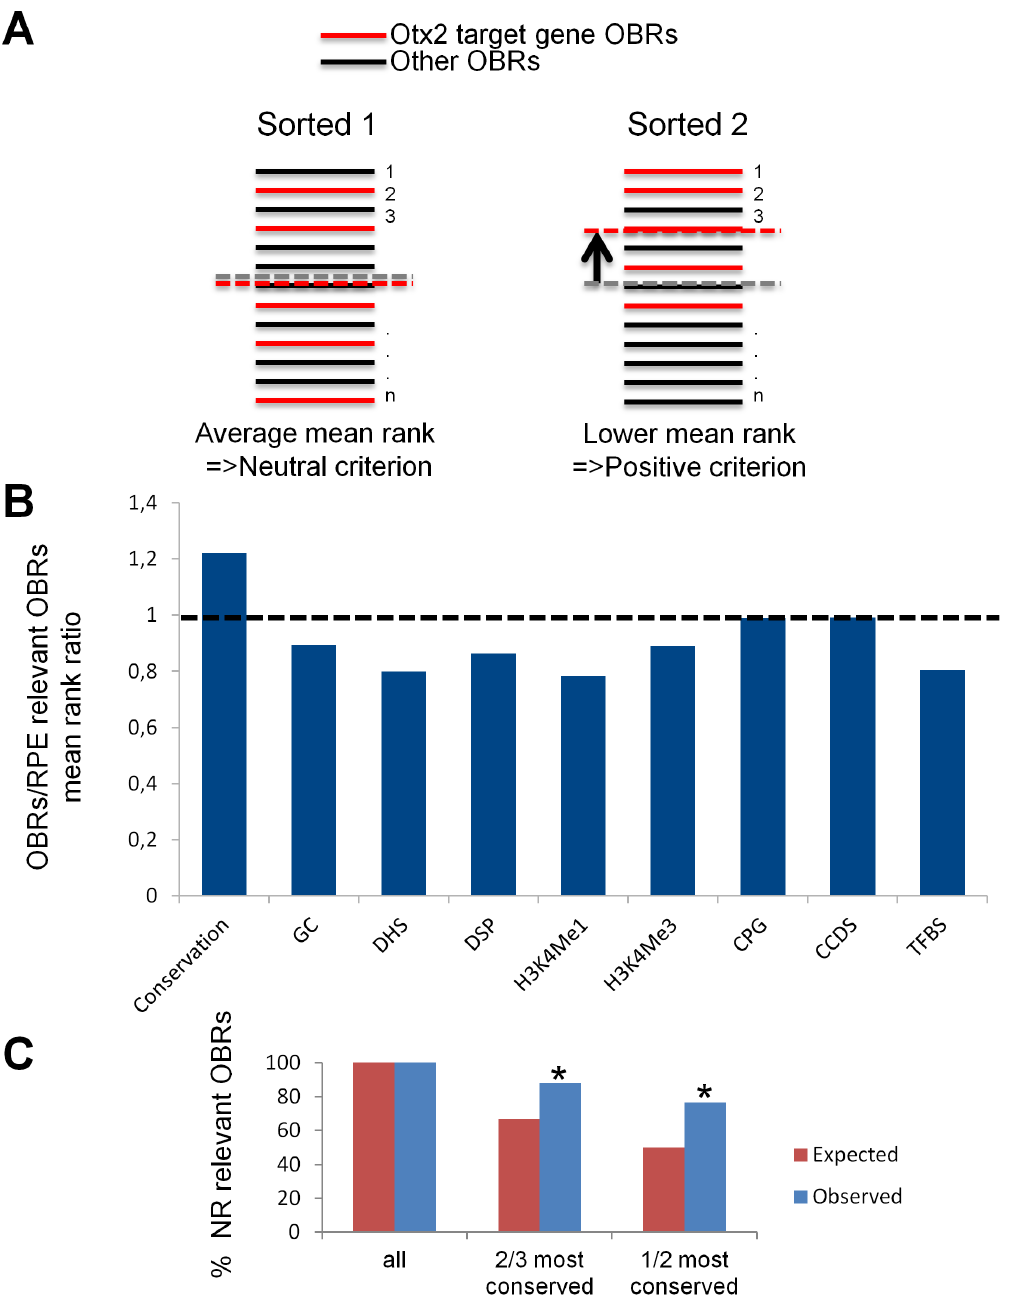
Figure 3. Evolutionary conservation marks OBR relevance. A. Principle of the relevance assay method: OBRs are sorted according to a given criterion and the mean rank of OBRs close to Otx2 target genes (red) is compared to the average mean rank of all called OBRs according to this criterion. A similar rank indicates a neutral criterion and a lower rank indicates a relevant criterion. B. Shown is the ratio of all OBRs mean rank to the mean rank of OBRs close to microarray confirmed Otx2 target genes according to evolutionary conservation, GC content, DNase hypersensibility (DHS) DNase sensibility and sensibility peaks (DSP), histone H3 lysine 4-mono- and tri-methylation (H3K4Me1, H3K4Me3), CpG islands (CPG), Consensus Coding sequences (CCDS) and known transcription factor bound regions (TFBS). The dashed line at the value of 1 represents the neutrality of all criteria. C. Application of the conservation criterion to the NR: expected and observed percentage of OBRs close to genes relevant to neural retina Gene Ontology terms among the 2/3 and 1/2 most conserved OBRs. doi:10.1371/journal.pone.0089110.g003 bracketed the Crx group, showing closer similarity to this Crx Next, the Otx2 NR and RPE core datasets were compared to group than to the Otx2 RPE group. This indicated that Otx2 the Crx ChIP-seq data in detail (Fig. 5B). Peak location analysis genome occupancy in the NR was more similar to Crx genome revealed a very large overlap between Otx2 NR and Crx peaks with 2822 overlapping peaks. On the contrary, Otx2 RPE and occupancy that to Otx2 genome occupancy in the RPE.